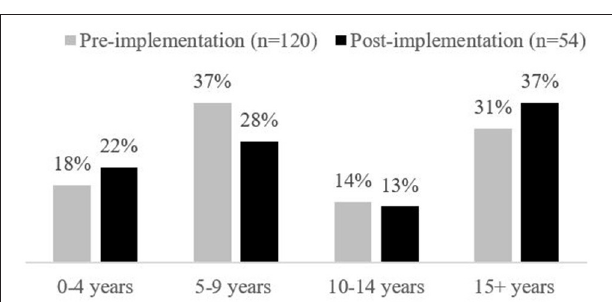
FIGURE 1 | Staff years of experience in